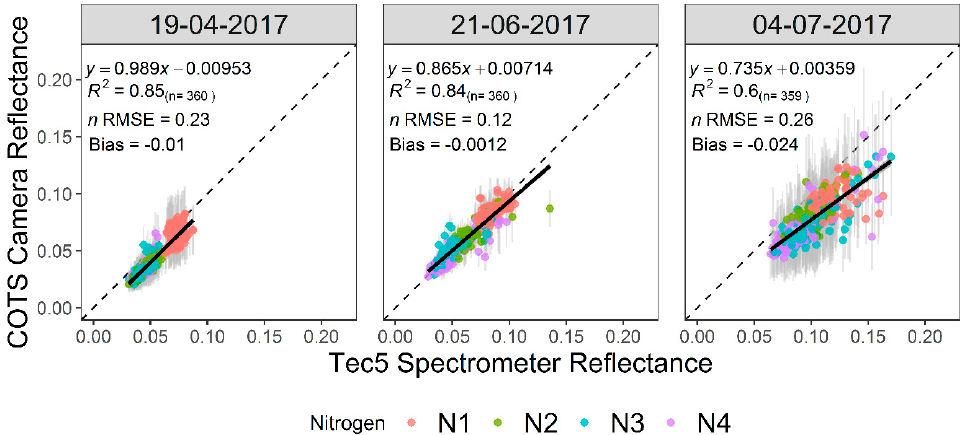
Figure 12. Accuracy assessments of green band reflectance for three dates. Tec5 reflectance is convolved to the spectral response of the COTS cameras for comparison. The points are coloured based on nitrogen treatment applied to the plot. Standard deviation of reflectance measured by the COTS cameras is presented by vertical error bars. The dashed line represents the 1:1 line.